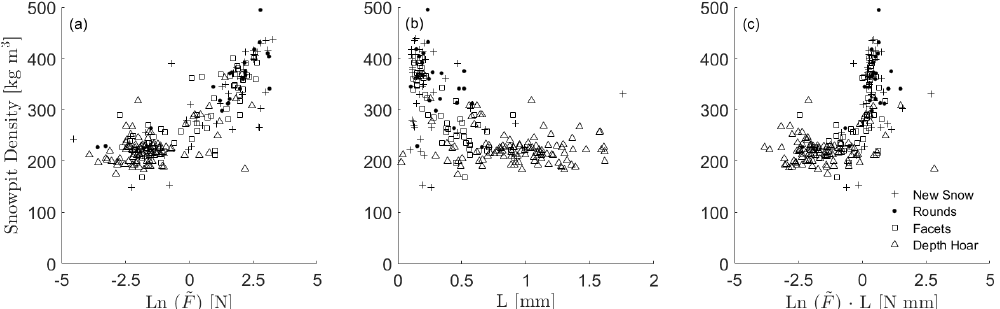
Figure A2. Relationships between the snowpit densities and SMP microstructural metrics from the paired profiles in the recalibration dataset, after Fig. 5 of King et al.